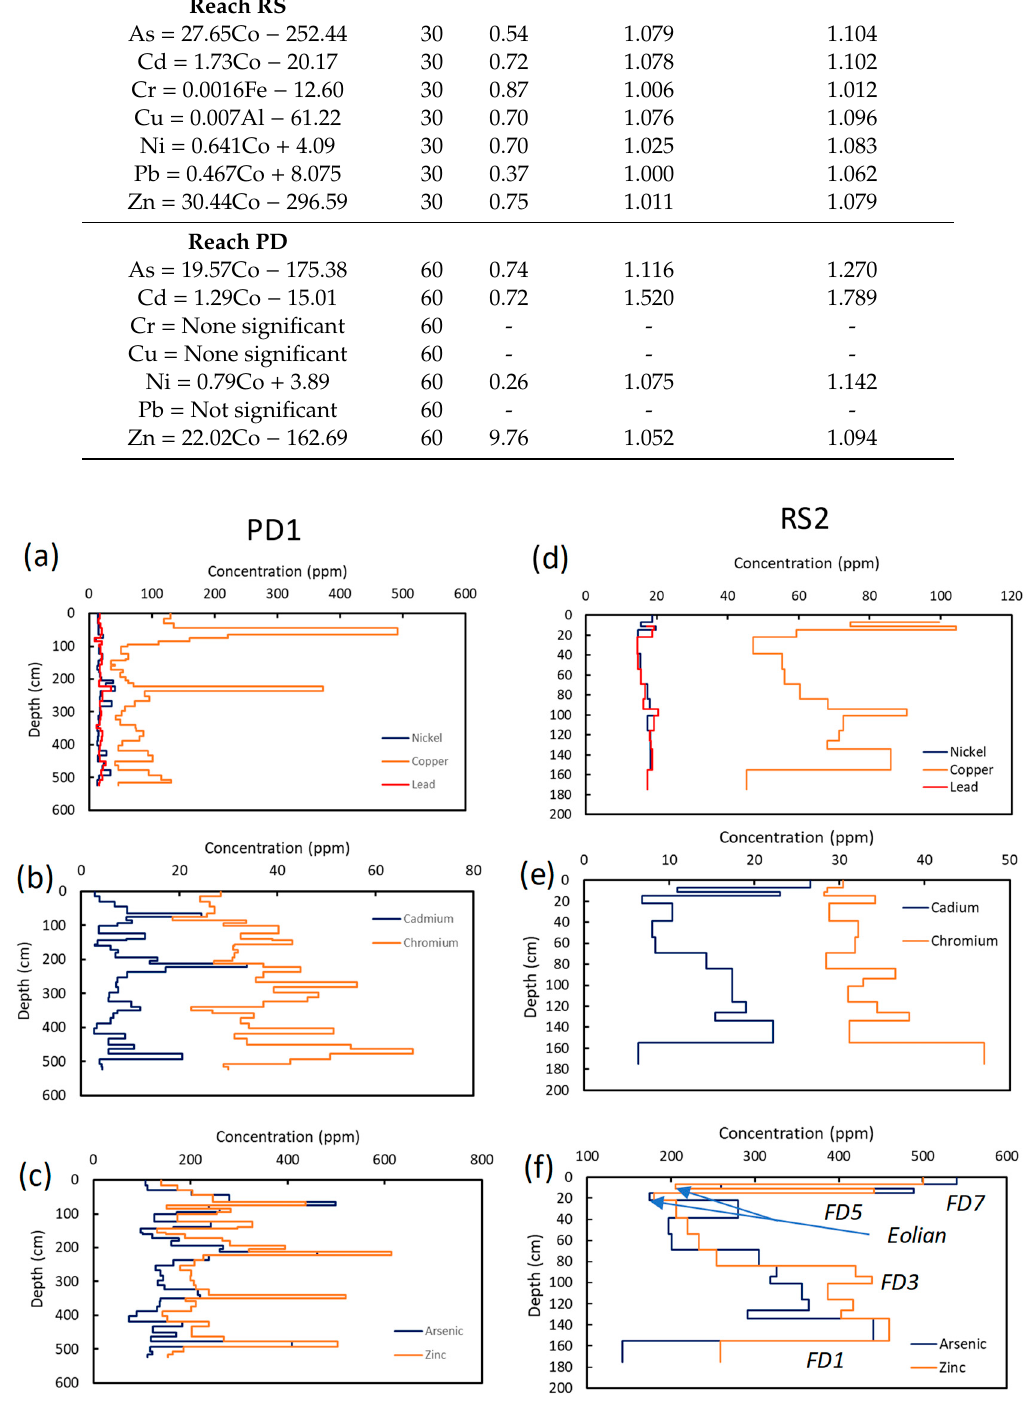
Figure 9. Comparison of the vertical variations in Ni, Cu, and Pb at PD1 ( a ) and RS2 ( d ); Cd and Cr at PD1 ( b ) and RS2 ( e ); As and Zn at PD1 ( c ) and RS2 ( f ). Variations at RS1 and PD1 are representative of deposits along the two reaches. Table 2. Descriptive statistics for selected geochemical parameters measured in the fine ‐ grained fraction by reach; values reported in mg/kg.